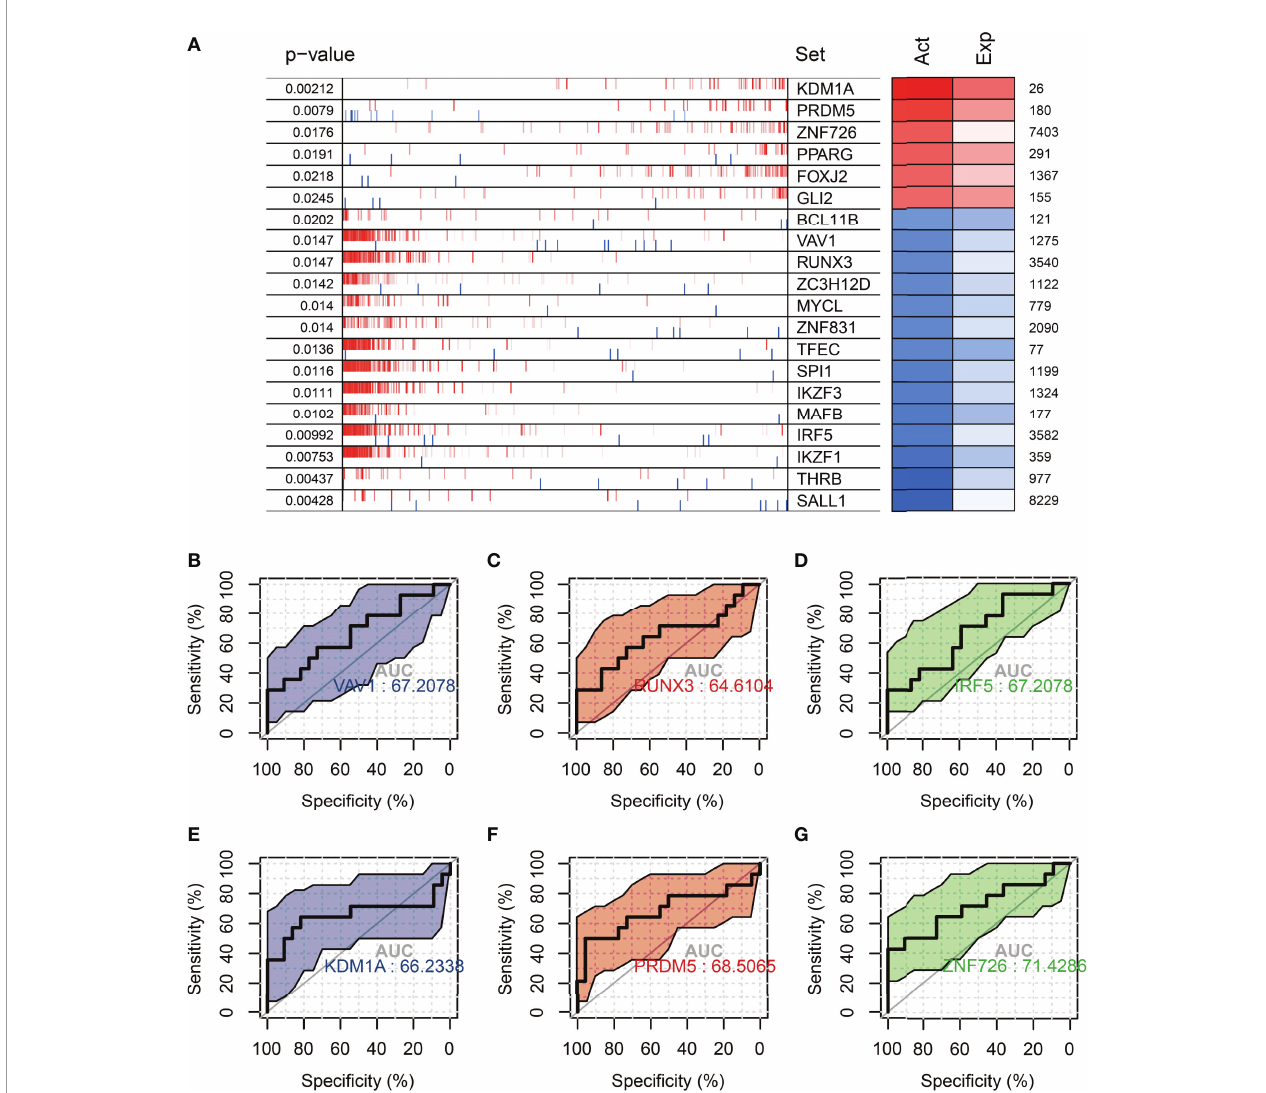
FIGURE 6 | Analysis of master regulators in the 20-29 age group vs. the 30-39 age group. (A) Top 20 transcription factors with differential protein activity enrichment (B – D) Signi fi cantly activated transcription factors in the 30-39 age group for the diagnosis of ovarian senescence in the reproductive years (VAV1, RUNX3, IRF5). (E – G) Signi fi cantly activated transcription factors in the 20-29 age group for the diagnosis of ovarian senescence in the reproductive age group (KDM1A, PRDM5, ZNF726). Act: TF activation; Exp: TF